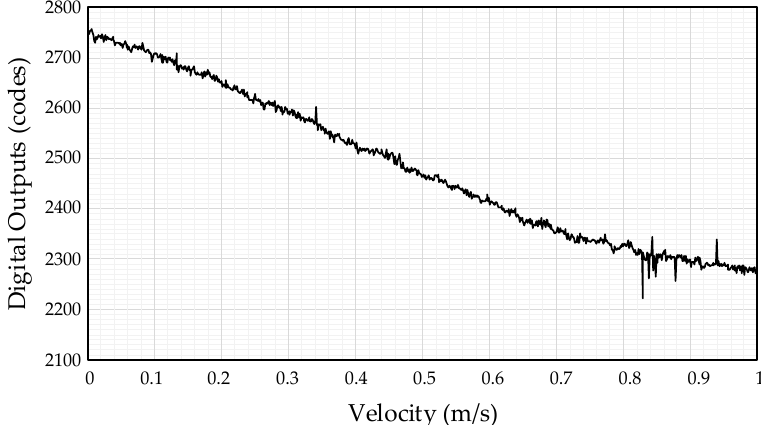
Figure 18. Digital code measurement result based on air flow velocity of readout IC. The minimum detectable air velocity can be calculated as below. The measured root- mean-square (RMS) noise with the integration bandwidth from 0.5 Hz to 200 Hz was 149.9 nV RMS , as shown in Figure 16. The gain of the amplifier was set to the maximum gain of 47.47 dB. The RMS output noise was calculated to be 35.4 µ V RMS . The peak-to-peak output noise could be calculated to be 234 µ V PP with typical conversion factor from RMS to peak-to-peak noise of 6.6. This output noise could be converted to 0.29 LSB with the 12-bit ADC with 3.3 V input range. Thus the minimum detectable air velocity could be calculated to be 0.6 mm/s (=234 µ V PP /(481 LSB/(m/s))). Figure 19a presents the air flow velocity measurement result of the Vicons and Figure 19b presents the air flow velocity measurement result of the proposed readout IC converted from digital codes to analog signal. Comparing these two graphs, the proposed readout IC shows accurate measurement of air flow.